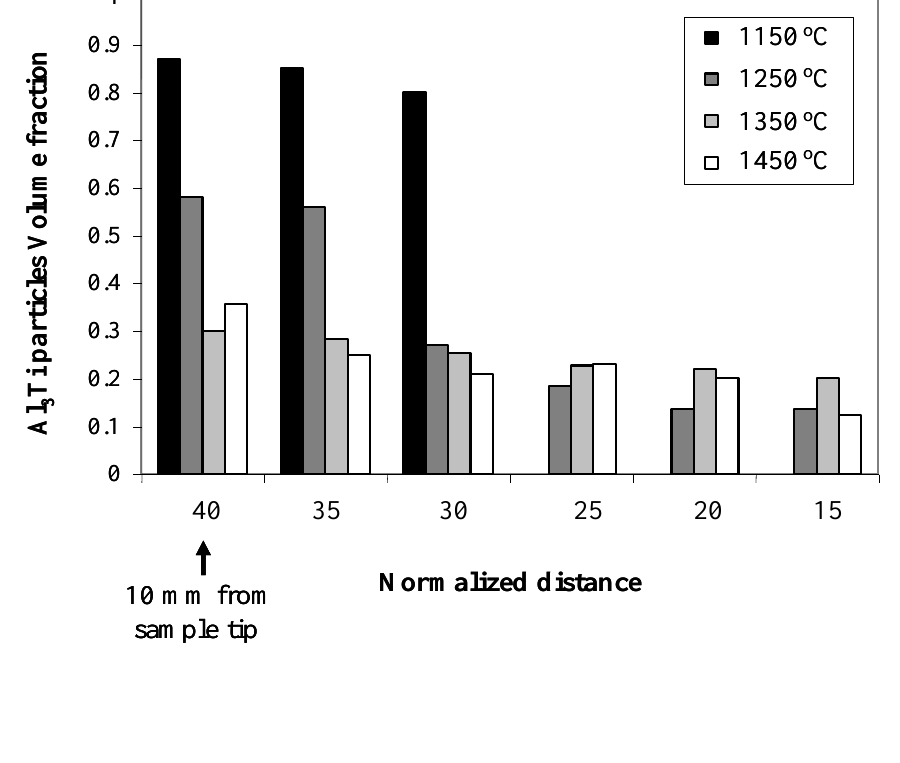
Figure 14. Al Ti particles volume fraction distribution at different processing temperatures 3